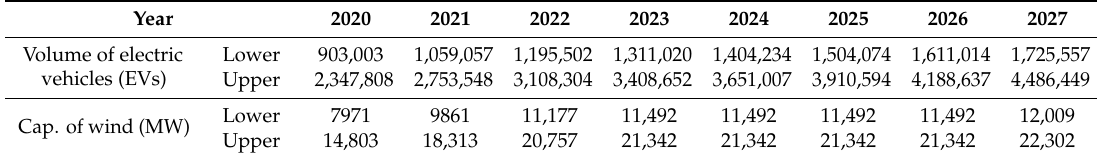
Table 3. Interval Data for Yearly Projected Deployment of Smart Grid Resources.